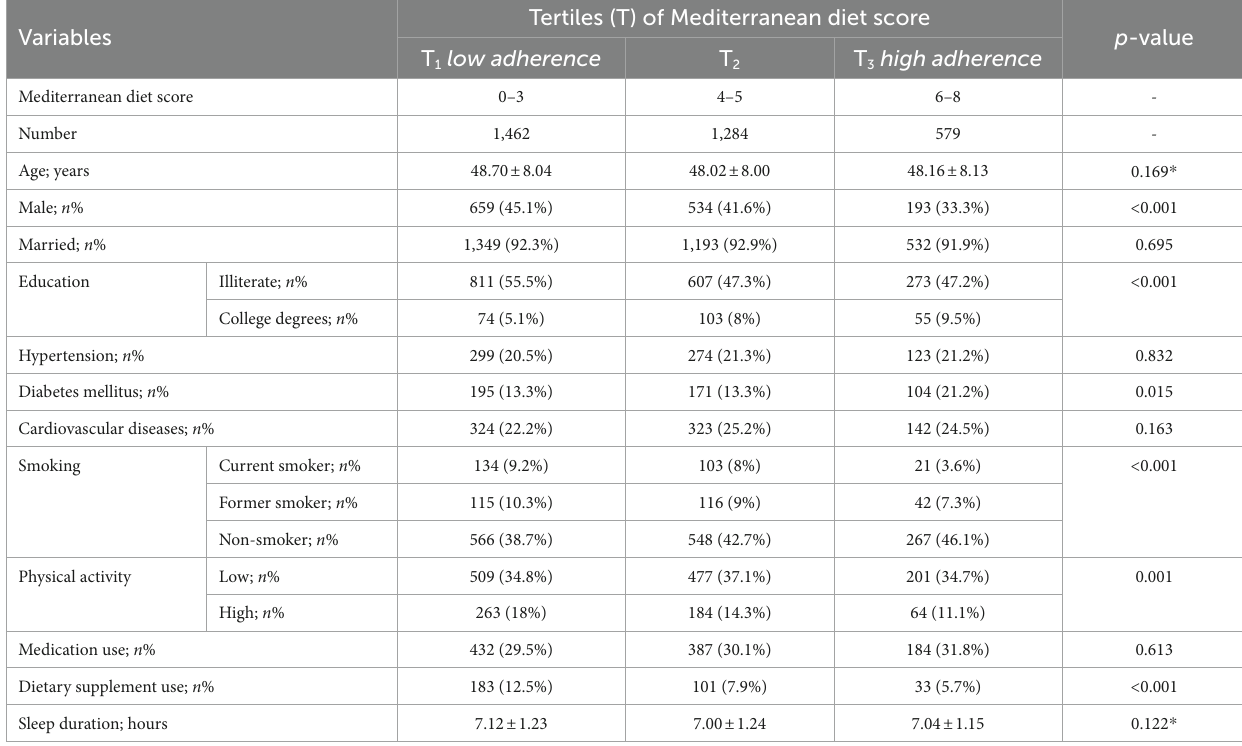
TABLE 2 Demographic characteristics of NAFLD (defined through the FLI) participants in the RaNCD cohort across the tertiles of the Mediterranean diet scores.